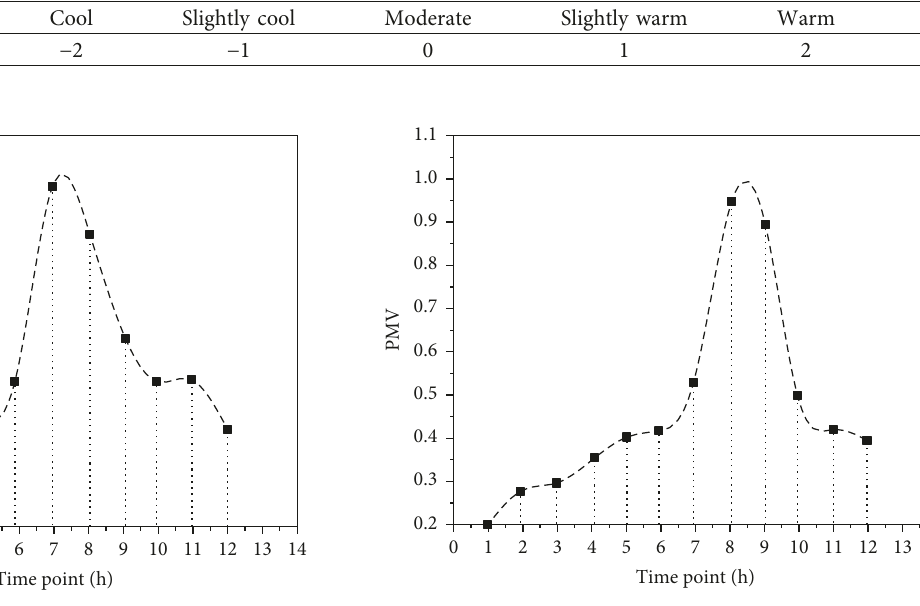
Figure 2: Variation of PMV with time at 25 ° C. Figure 3: Variation of PMV with time at 26 ° C.